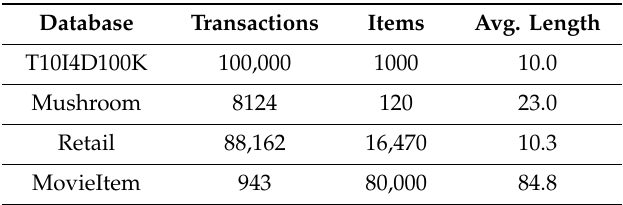
Table 6. Characteristics of the databases used for the experiments.